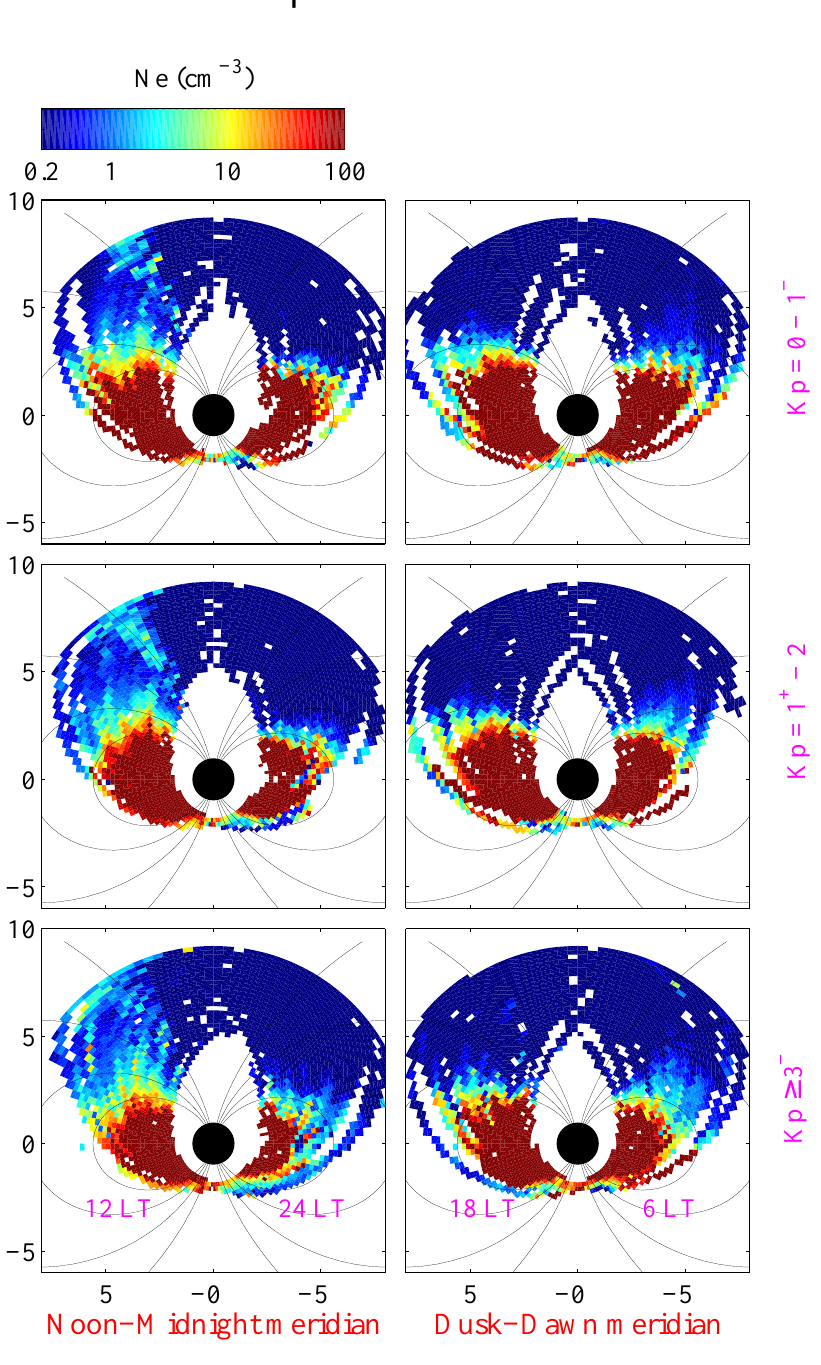
Fig. 3a. (a) Average electron density in two meridional planes (scales in R E ): left panels are for the noon-midnight meridian, and right panels are for the dusk-dawn meridian. The panels from top to bottom are for three different K p levels: K p = 0–1 − , K p = 1 + − 2 and K p ≥ 3 − . The lines in each panel rep- resent dipole magnetic field lines at in- variant latitudes of 65 ◦ , 70 ◦ , 75 ◦ , and 80 ◦ . (b) Number of counts used for the calculation of the average